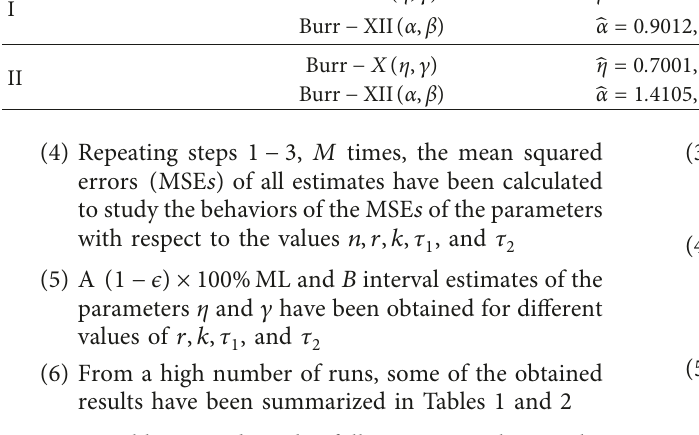
Table 3: -MLE s of the parameters and the associated K − S and P − Value based on the real data set I and II. Sample